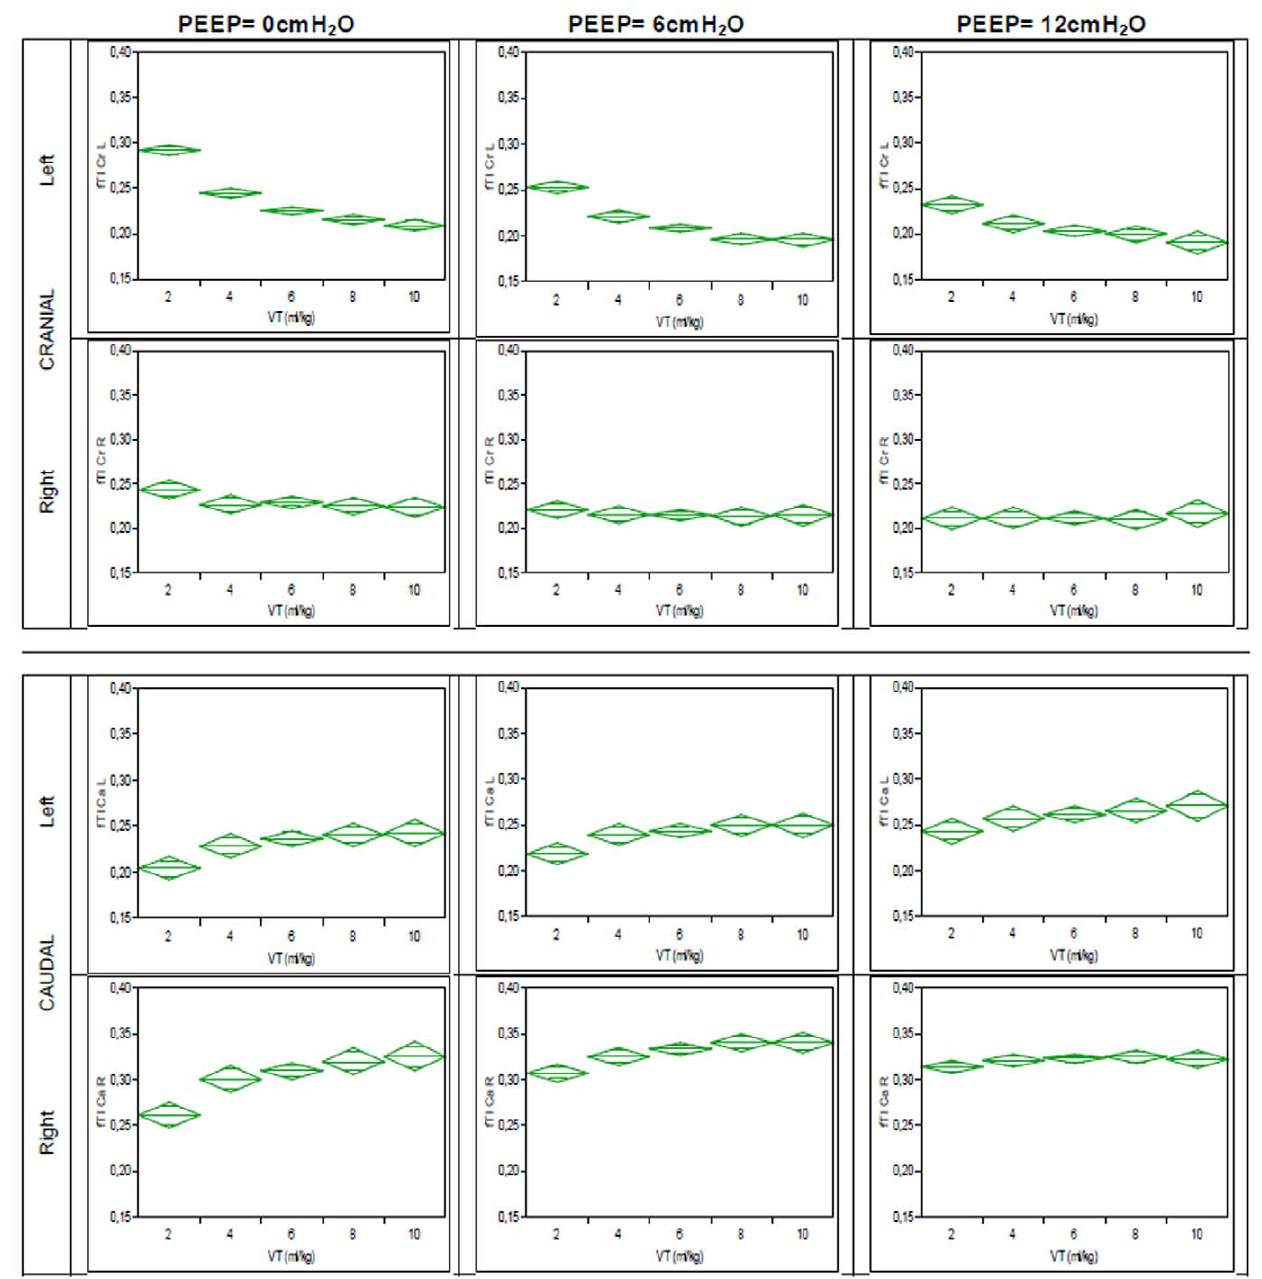
Figure 8. Distribution of fTI at different VT stratified according to PEEP, pre-lavage. Shown are mean fTI values (grey line) for different VT at different PEEP with 95%-Confidence Interval of the mean (green